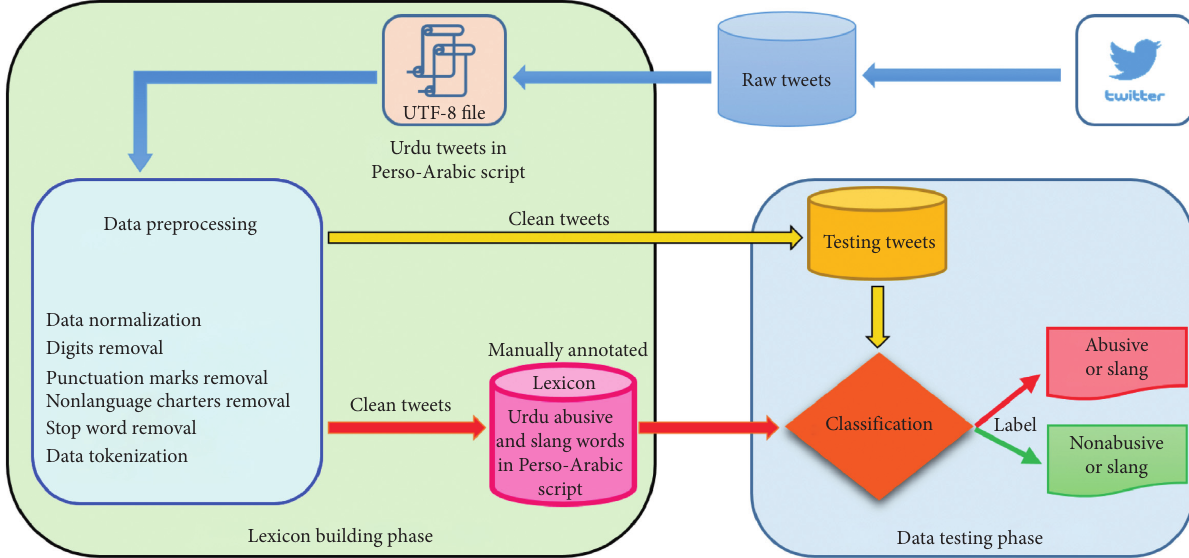
Figure 2: The architecture of the proposed Urdu Slang and Abusive Words Detection (USAD) model. Table 1: Lexicon and testing dataset